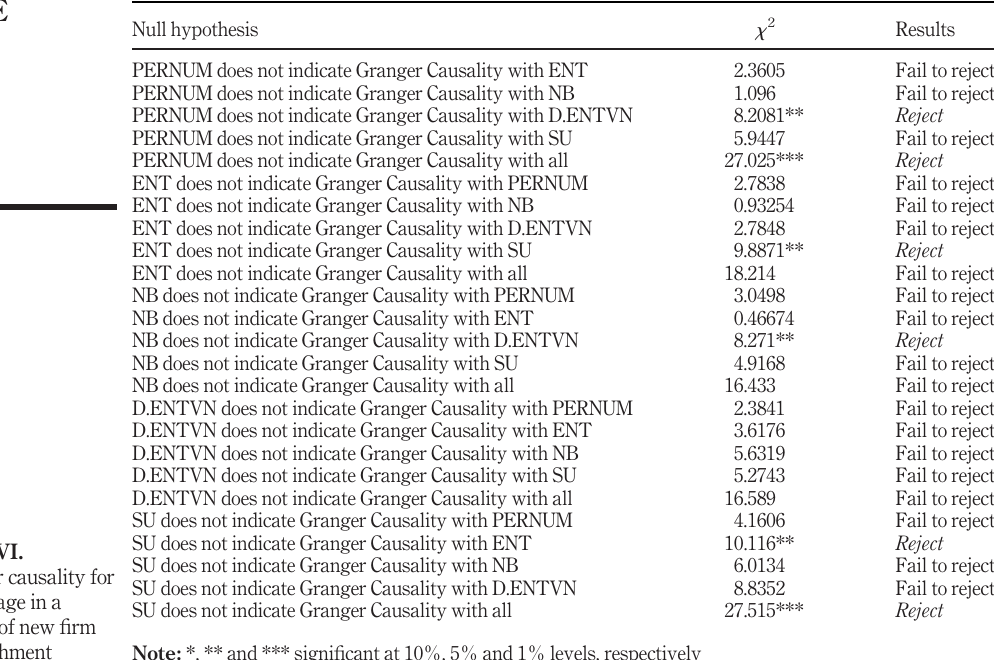
Table VI. Granger causality for percentage in a change of new fi rm